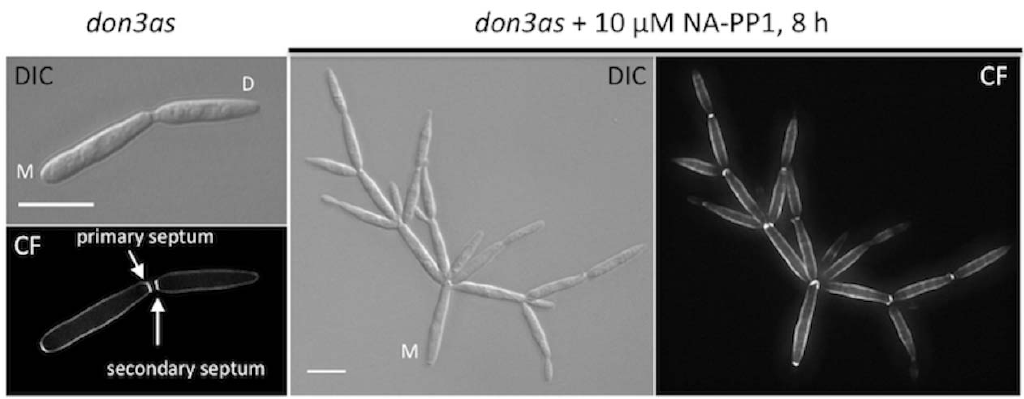
Figure 1. Inhibition of Don3as results in a septation defect. Cells expressing don3as were grown to an OD = 0.1 and split in media with or without inhibitor. After further growth 600 for 8 h (doubling time of U. maydis : 2 h) cells were stained with Calcofluor white (CF). The respective brightfield images are shown (DIC, M: mother cell; D: daughter cell). (Scale bars: 10